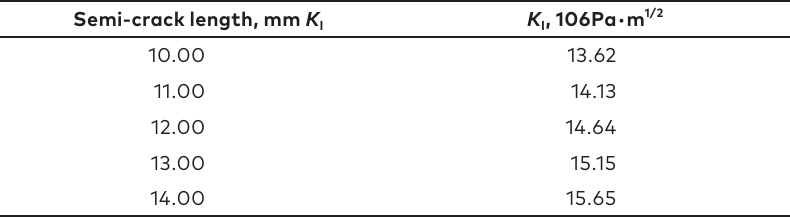
Table 3. The stress intensity factors of the crack front points ( n =